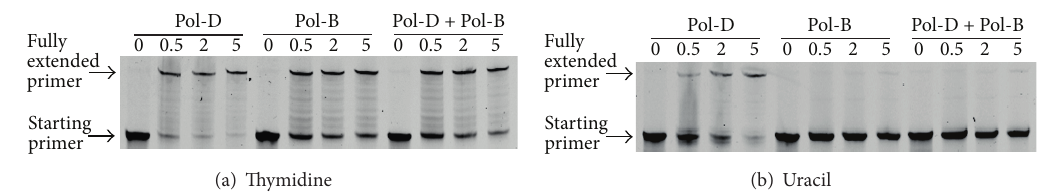
Figure 3: Inhibition of DNA polymerase-D by DNA polymerase-B in the presence of template strand uracil. (a) Extension of a thymidine- containing (control) primer-template by Pol-D, Pol-B, and a mixture of Pol-D and Pol-B. (b) Extension of a uracil-containing primer-template by Pol-D, Pol-B, and a mixture of Pol-D and Pol-B. The numbers above the gel represent the extension time in minutes. In these experiments wild type (exo + ) Pol-D and Pol-B were used. These experiments were carried out three times and in every case complete inhibition of Pol-D by Pol-B was noticed when uracil was present in the